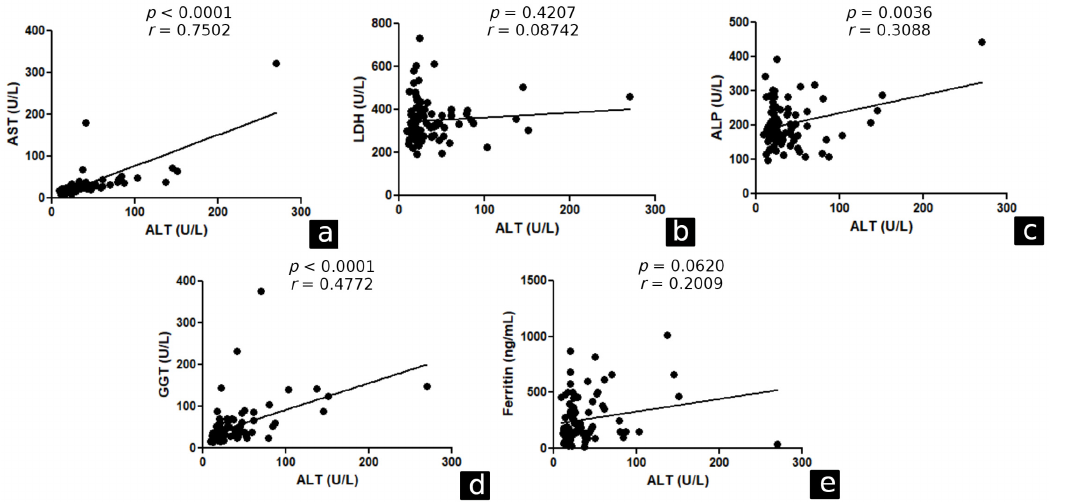
Figure 3. Correlation between ALT and liver function markers in patients who were hospitalised during acute COVID-19. Belém/PA, 2020–2021. ALT: alanine aminotransferase, AST: aspartate ami- notransferase, LDH: lactic dehydrogenase, ALP: alkaline phosphatase, GGT: gamma-glutamyl transferase. ( a ) correlation between ALT and AST. ( b ) correlation between ALT and LDH. ( c ) corre- lation between ALT and ALP. ( d ) correlation between ALT and GGT. ( e ) correlation between ALT and